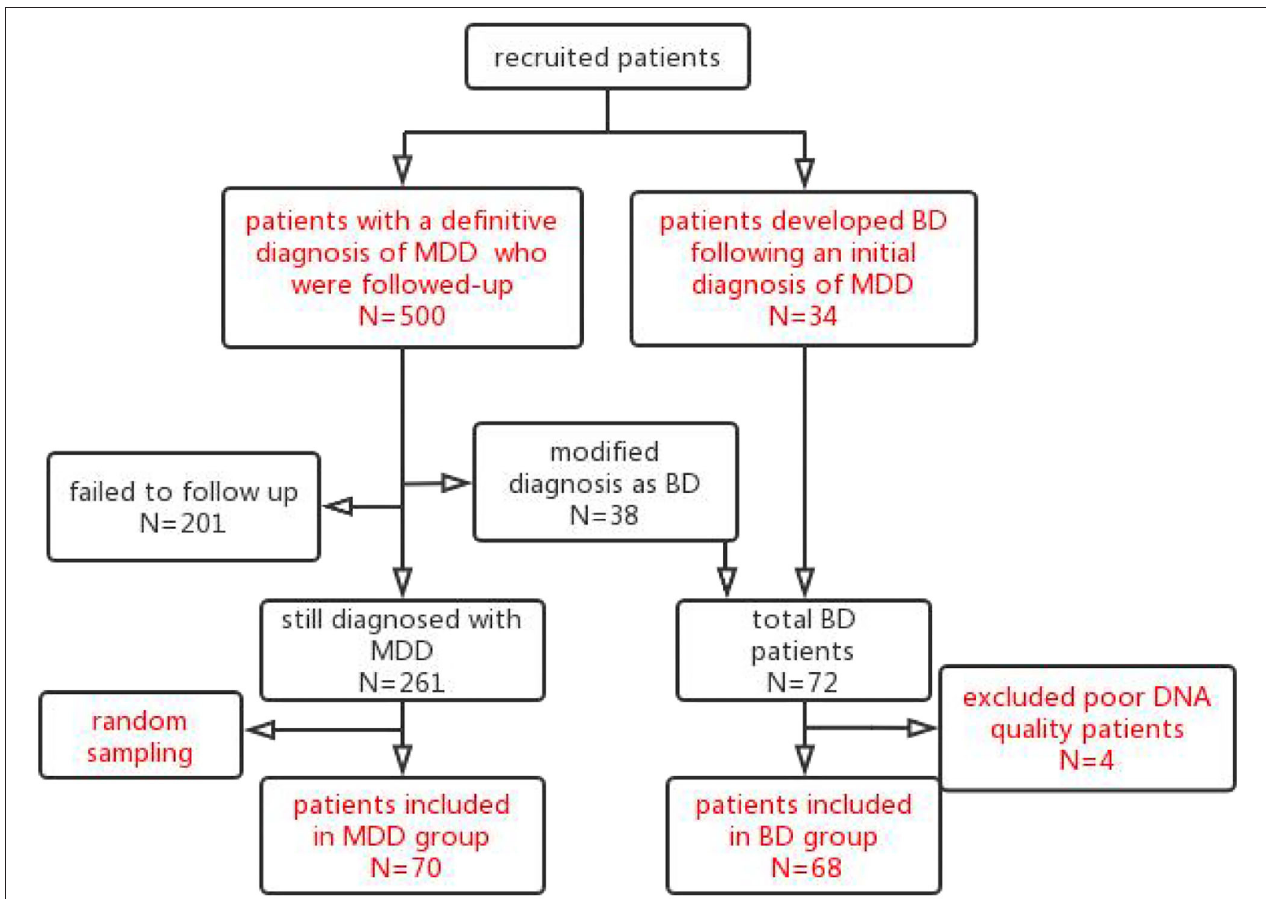
FIGURE 1 | Patients flow chart throughout the trial. The 500 patients with an initial diagnosis of MDD were recruited and followed up after 5 years. In total, 299 subjects were followed up successfully. Of these 299 subjects followed up successfully, 38 subjects met the criteria for a diagnosis of BD and were included in the BD group. Furthermore, from a retrospective review of inpatient medical records, another 34 patients were identified who developed manic symptoms following an initial diagnosis of MDD and were included in the BD group. Of the total 72 BD patients, 4 patients with poor DNA quality were excluded. Finally, 68 patients were included in the BD group. Of the 261 patients with MDD who followed-up successfully with a stable diagnosis of MDD, a subgroup of 70 subjects was selected by random sampling for the MDD group.